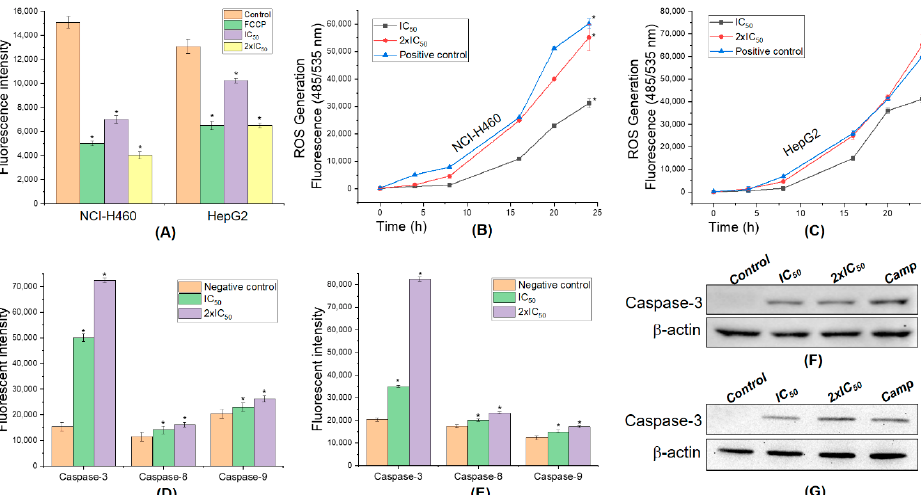
Figure 8. Potential mechanism of action of 5,4’ ‐ dihydroxy ‐ 6,7,8,3’ ‐ tetramethoxyflavone on human liver and lung cancer cells. ( A ) Mitochondrial membrane potential; ROS production in NCI ‐ H460 ( B ) and